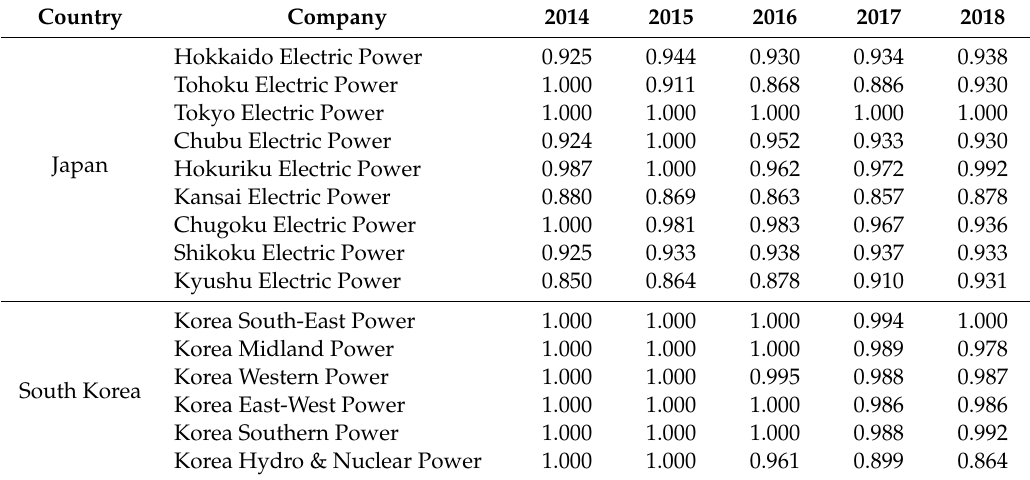
Table 7. Efficiencies of Japanese and Korean Power Companies with Multiplier Restriction. Country